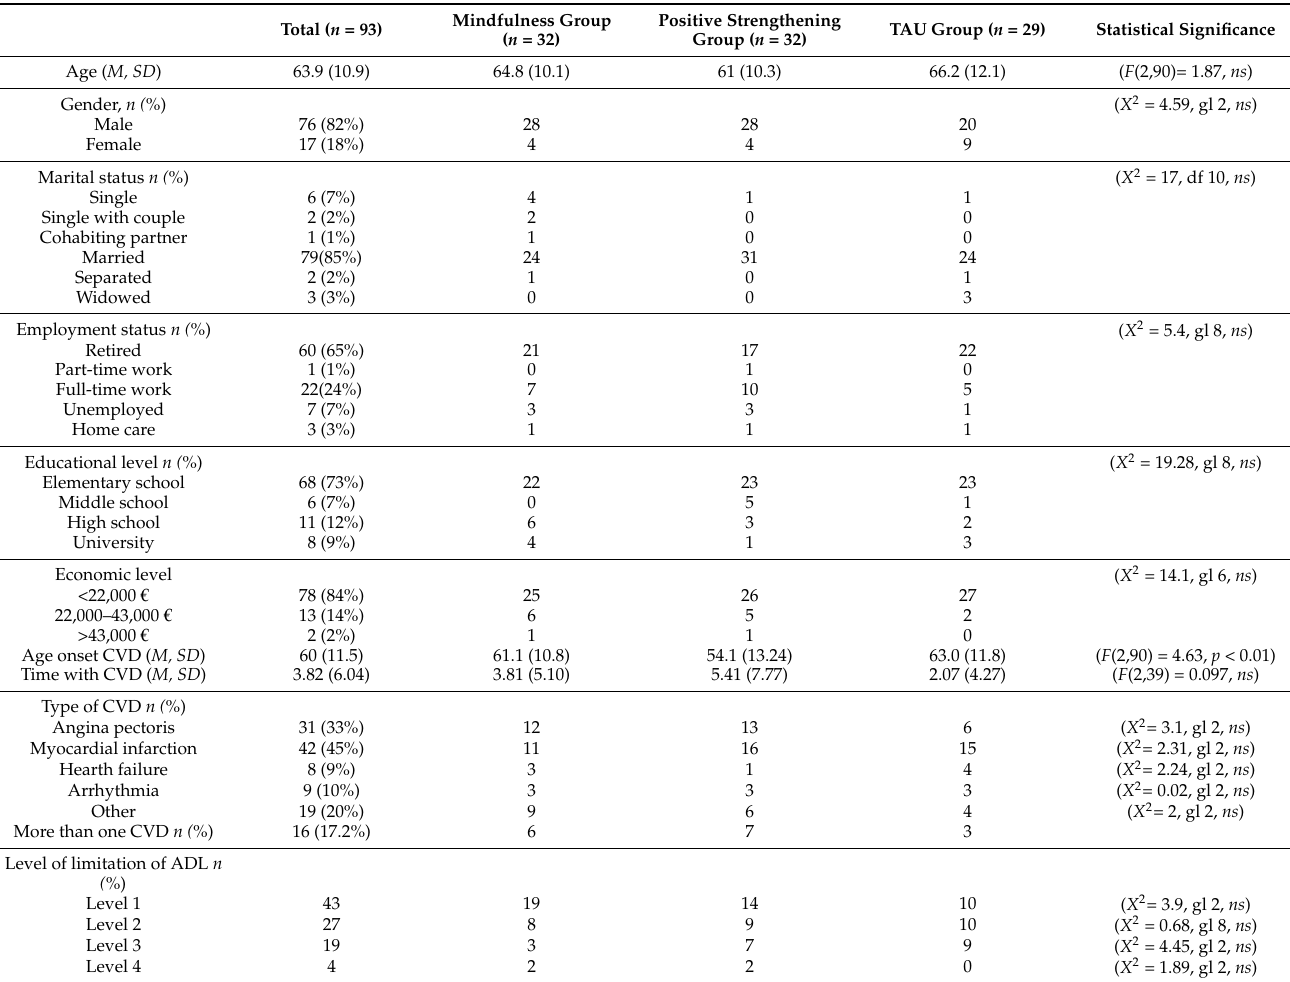
Table 1. Demographic and clinical